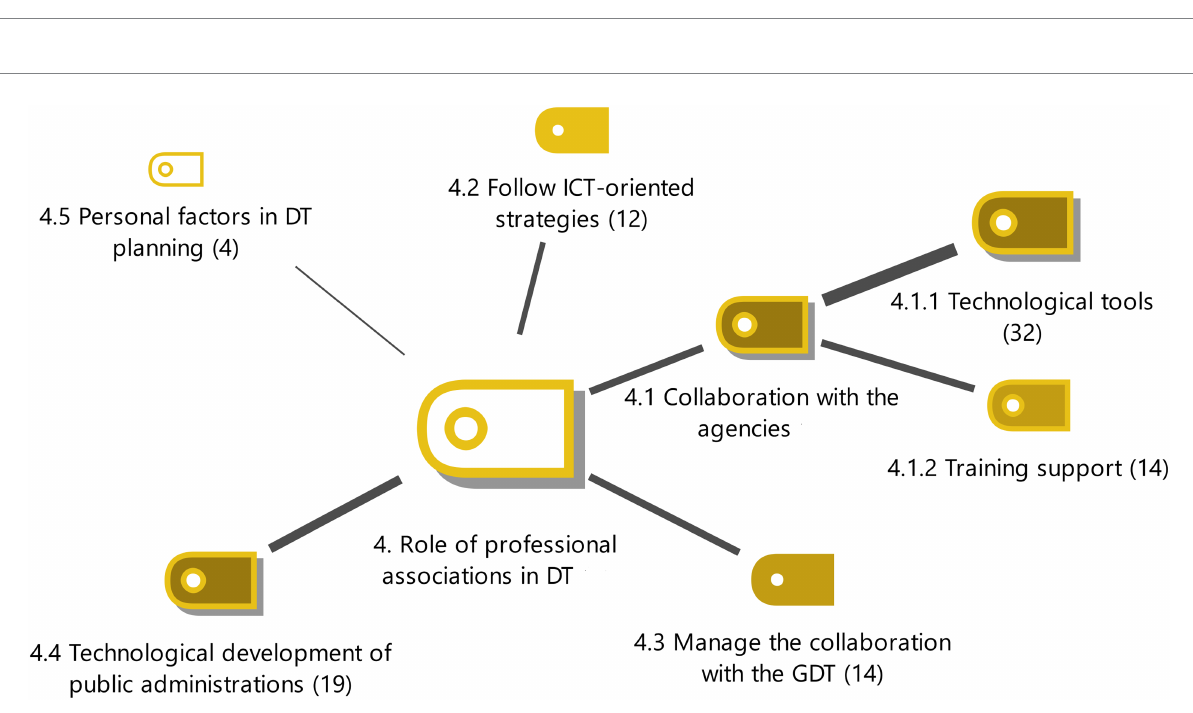
FIGURE 4 Role of professional associations in DT with the weighting of the properties. Source: Authors